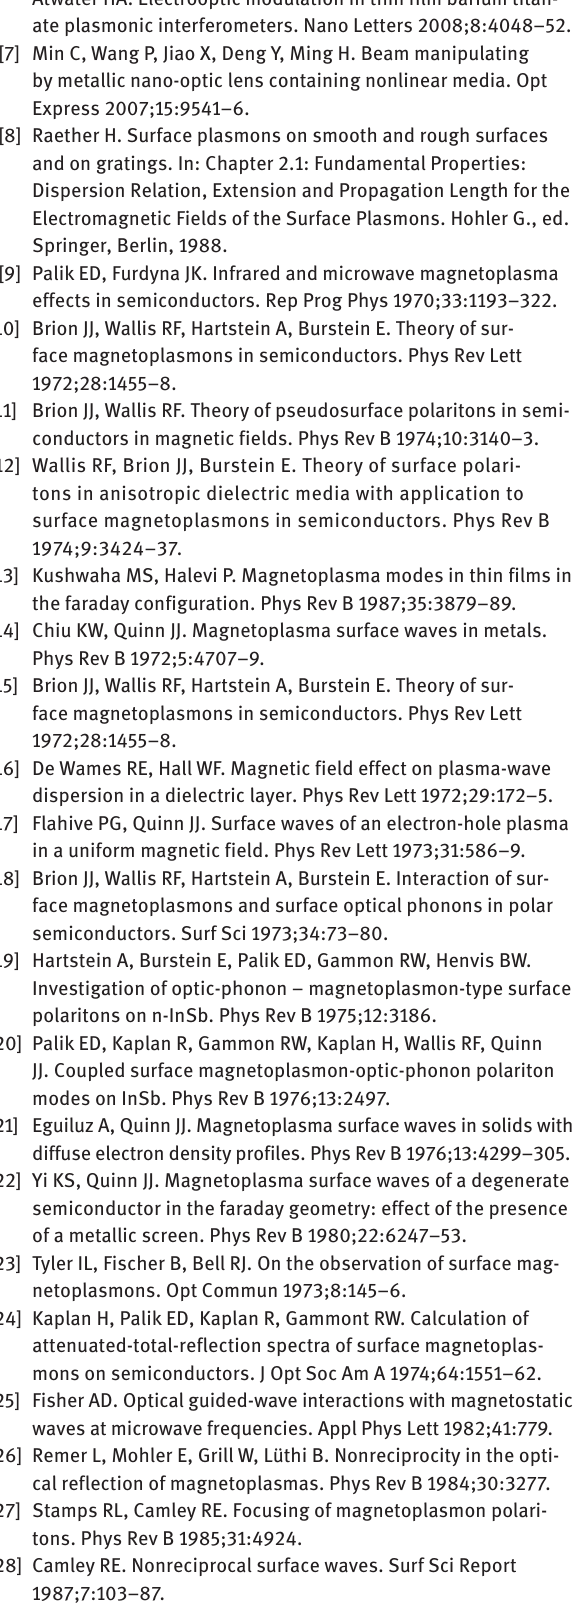
of single layer graphene, SMPs in double layer graphene have two modes: symmetric and antisymmetric modes (Figure 12C and D). Although the magnetic field has little effect on the coupling of the symmetric and antisym- metric modes, the decoupling of these two modes can be achieved by varying the doping levels of the two graphene